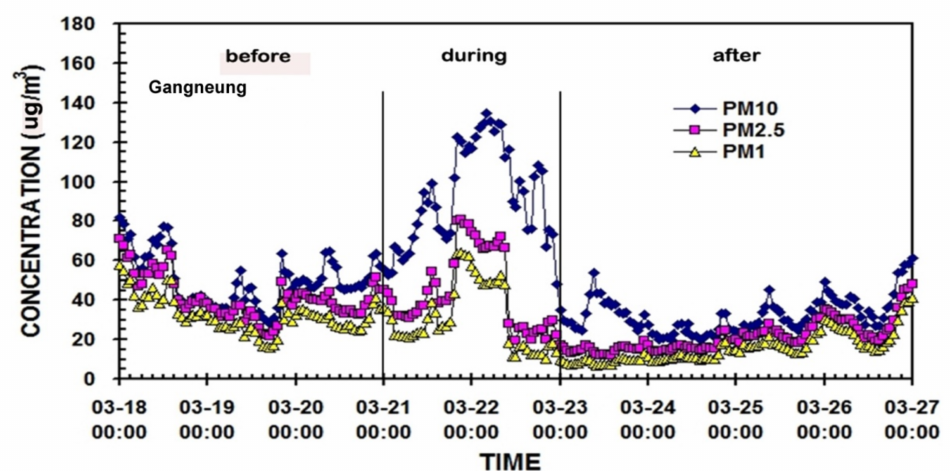
Figure 3. Hourly distribution of PM 10 , PM 2.5 and PM 1 concentrations, before, during and after the dust period from 18 to 27 March, 2015 at Gangneung city, Korea.